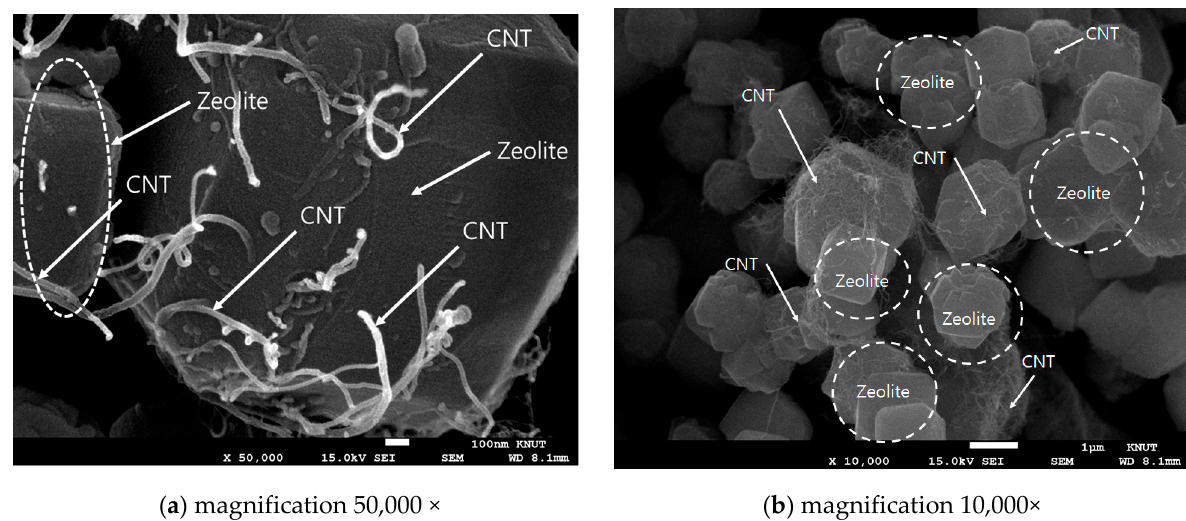
Figure 1. Impregnation process with MWCNTs and porous powder. Table 3. Particle size distribution of silica sand (mass fraction).